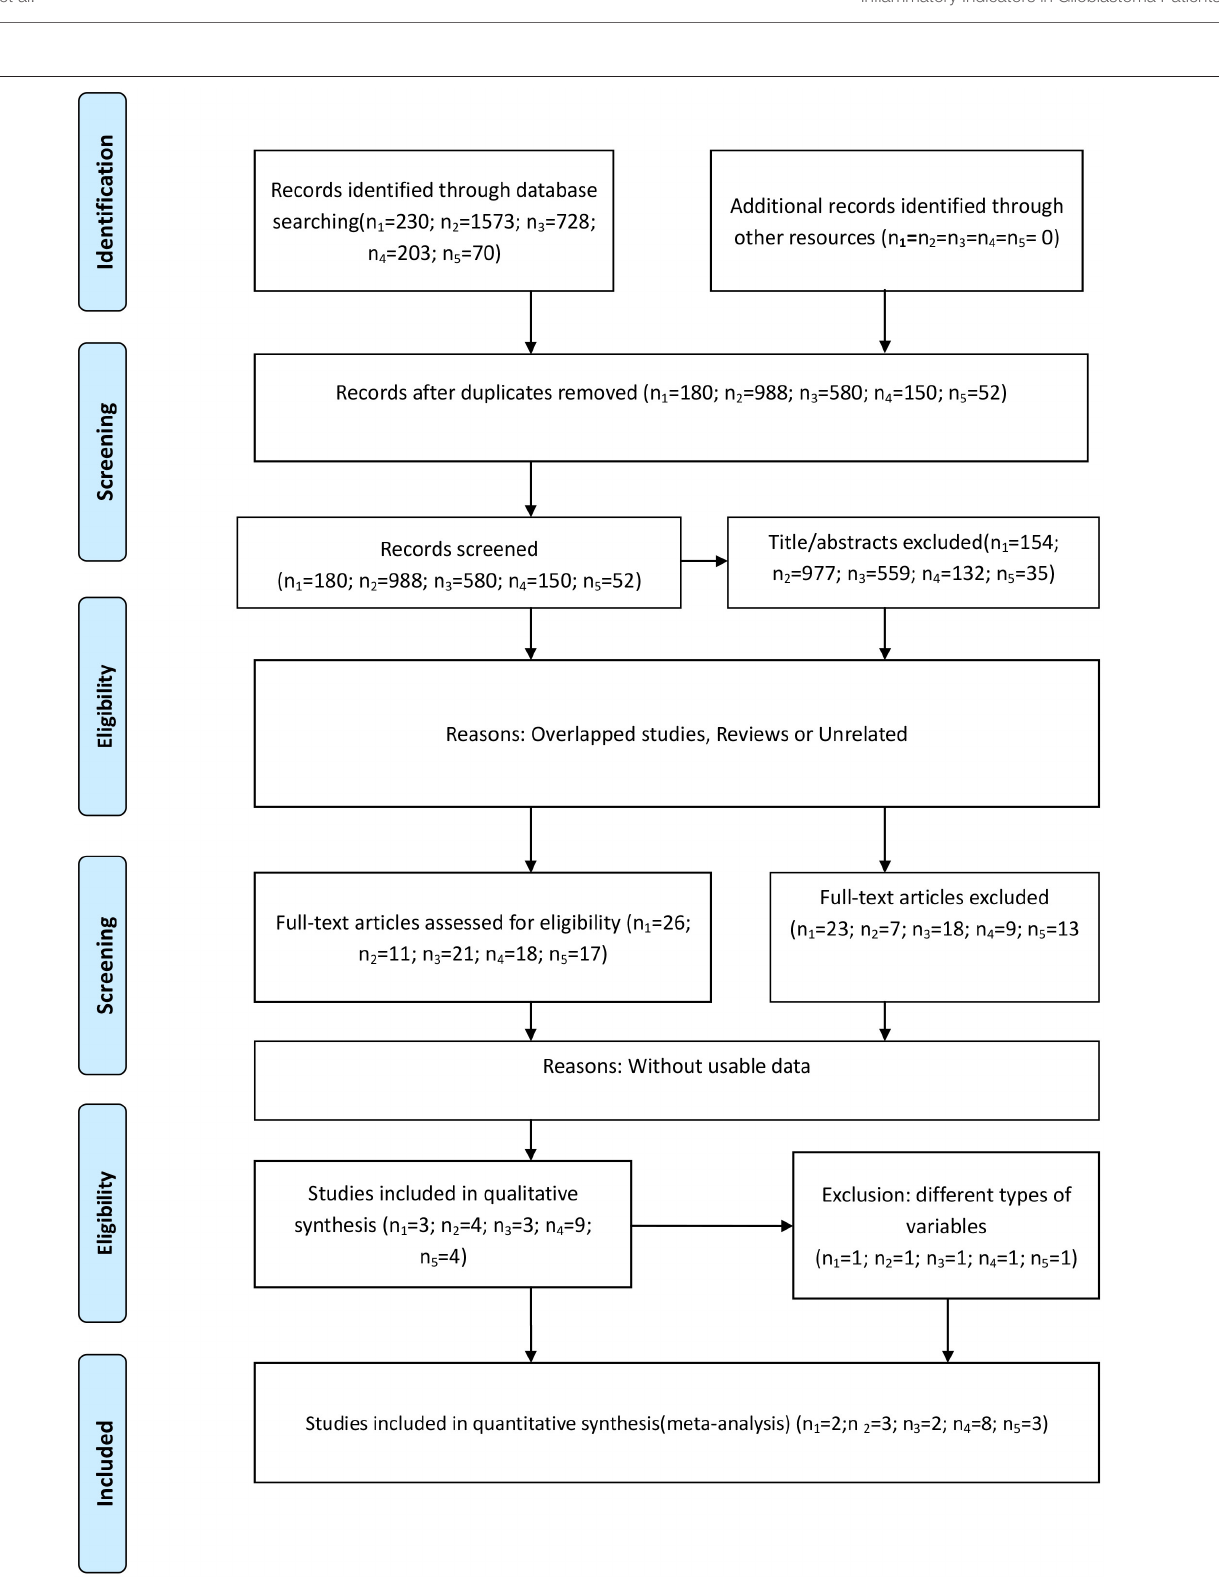
FIGURE 1 | Flow diagram of the study selection process. (n 1 -n 5 represent the numbers of incorporated literature of neutrophils, lymphocytes, platelets, NLR, and PLR, respectively).